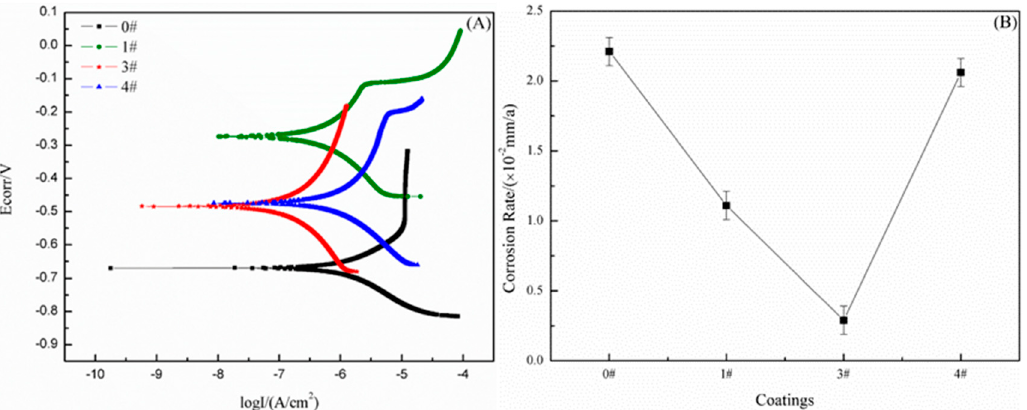
Figure 5. ( A ) Polarization curves and ( B ) corrosion rates of different SHWPUCs immersed in 3.5 wt % NaCl solution at 40 °C for 30 days.